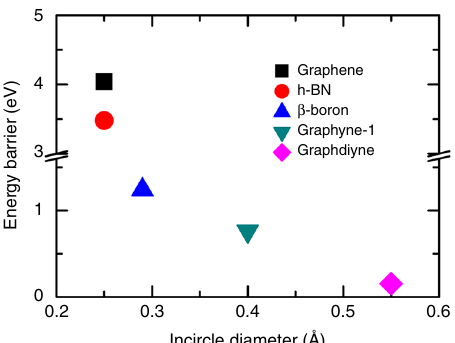
Fig. 6 Energy barriers for proton transport across different two-dimensional (2D) membranes